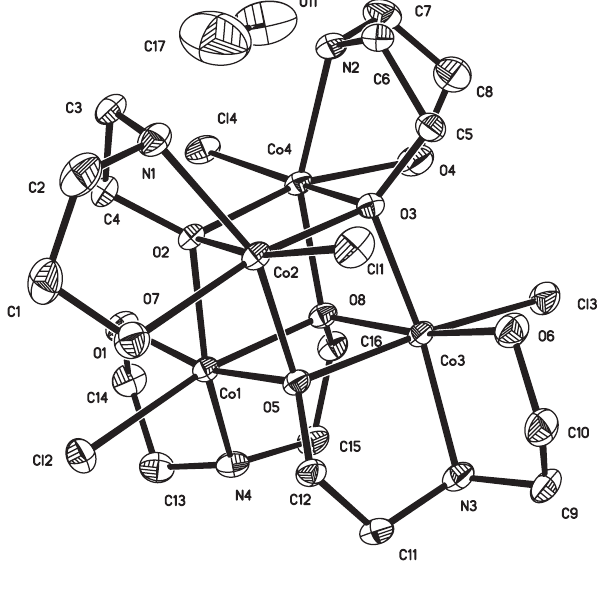
Table 1: Data collection and